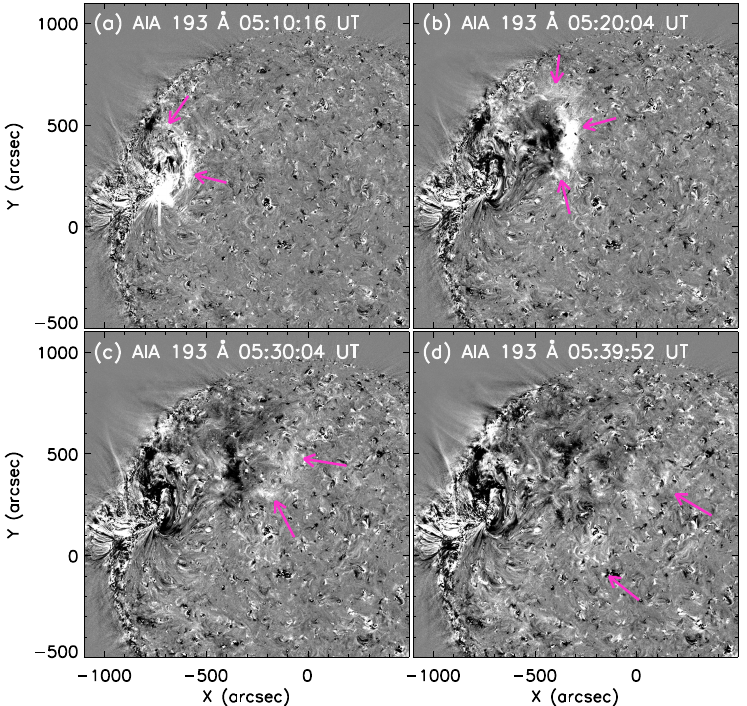
Figure 2. Evolution of the base difference images in AIA 193 Å revealing the wave propagation. The base image is selected at 04:50:04 UT. The pink arrows indicate the propagation of the